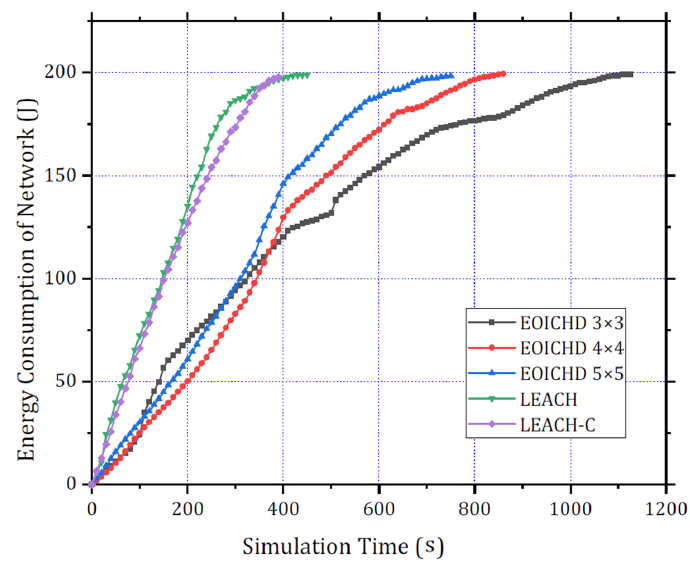
Figure 10 Figure 10. Energy consumption of network over simulation period Scenario #2.